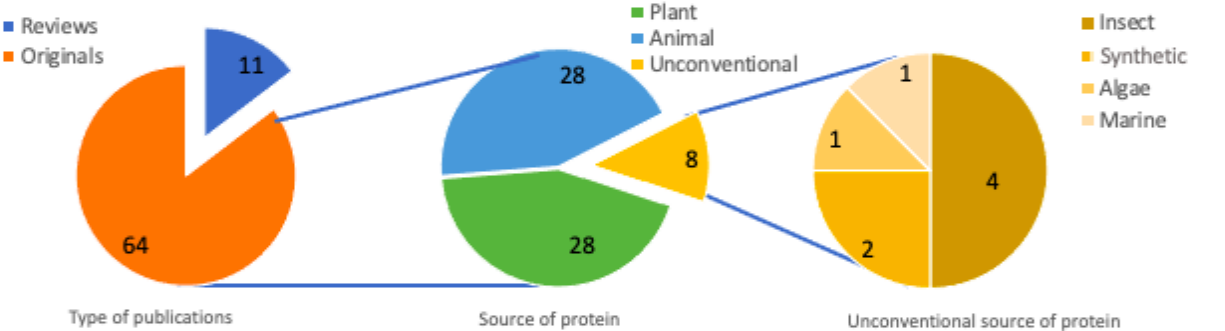
Figure 4. Source of the proteins used in the selected studies.